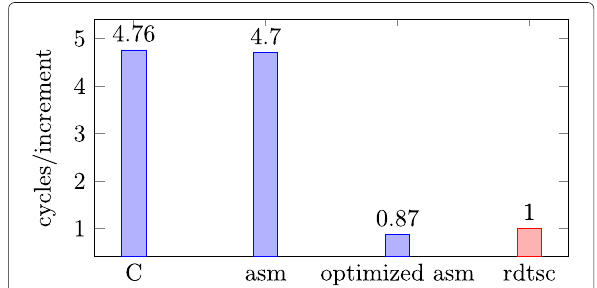
Fig. 3 Comparison of different variants for the counter thread to Intel’s native timestamp counter as the